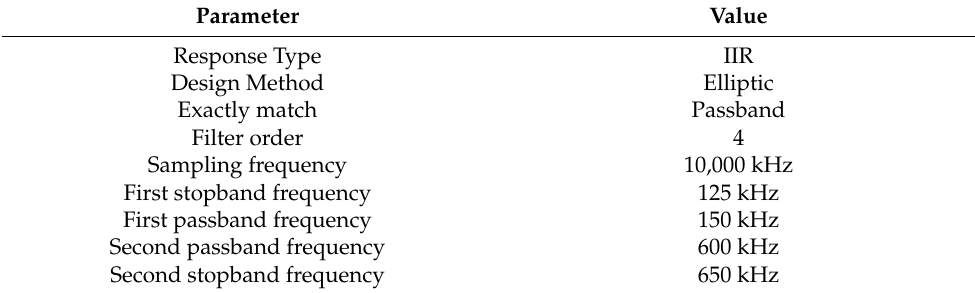
Table 2. Filter design